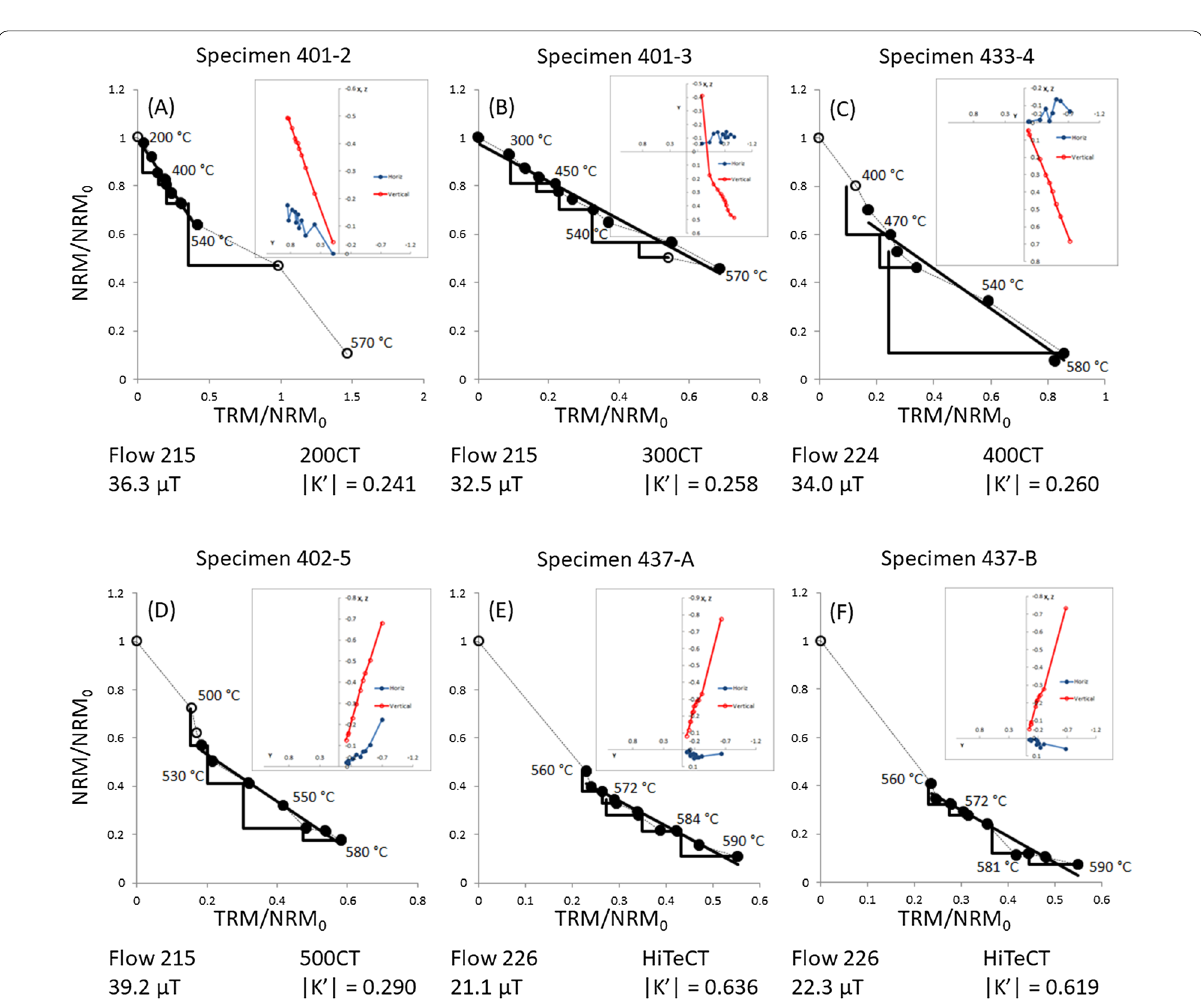
Fig. 4 Representative specimens from each type of experiment run herein. A – D Examples of standard Coe–Thellier experiments with starting temperatures from 200 to 500 °C. E and F are the two passes from the HiTeCT